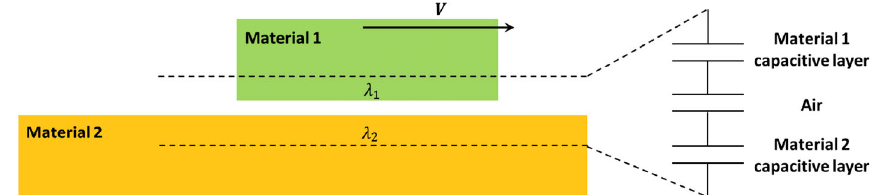
Fig. 1 The capacitive configuration for triboelectric